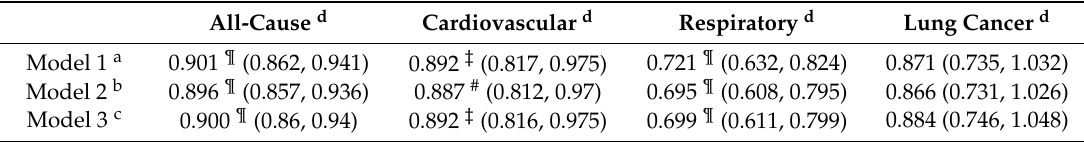
Table 2. Association between NDVI and Mortality.